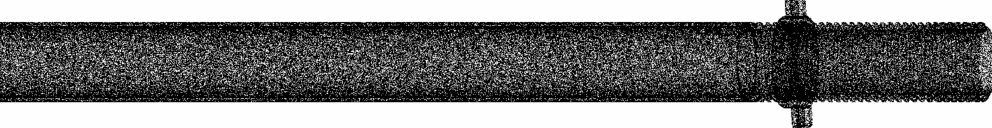
Figure 6. Sampled point